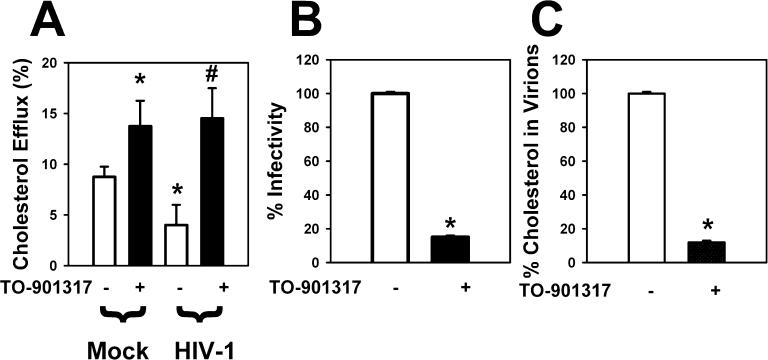
Cholesterol Efflux and Infectivity of HIV VirionsHuman monocyte-derived macrophages were infected with HIV-1 ADA or mock-infected, and 7 d after infection were treated or not treated with LXR agonist, TO-901317 (500 nM), for seven more days.(A) Cholesterol efflux to apoA-I was measured on day 21 after infection. An asterisk (*) indicates p < 0.01 (versus uninfected cells not treated with TO-901317); a number sign (#) indicates p < 0.01 (versus HIV-infected cells not treated with TO-901317).(B) Virions were collected from culture supernatants of LXR agonist-treated and untreated (control) cells on day 10 and day 14 (pooled together), adjusted according to p24 content, and analyzed for infectivity on indicator P4-CCR5 cells. Experiment was performed in triplicate, and results (mean ± SD) are presented as percent infectivity of virions produced by control cells; an asterisk (*) indicates p < 0.001.(C) Incorporation of [3H]cholesterol into virions produced by LXR agonist-treated and untreated (control) cells was measured in triplicate, and results (mean ± SD) are presented relative to cholesterol in the virions produced by control cells; an asterisk (*) indicates p < 0.001.